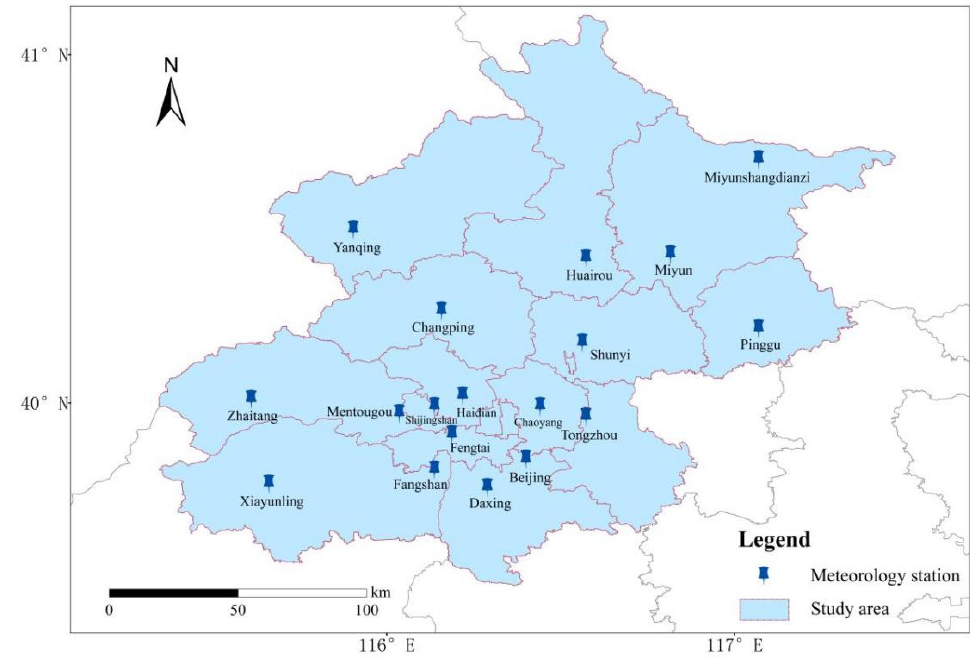
Figure 1. Distribution of the meteorological stations in the study area.